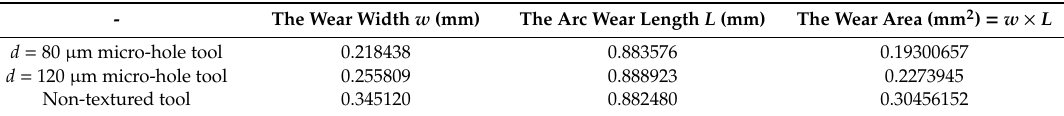
Figure 4. Tool wear: ( a ) d = 80 µm micro-hole tool; ( b ) d = 120 µm micro-hole tool; ( c ) non-textured tool. Table 5. The data of tool wear.